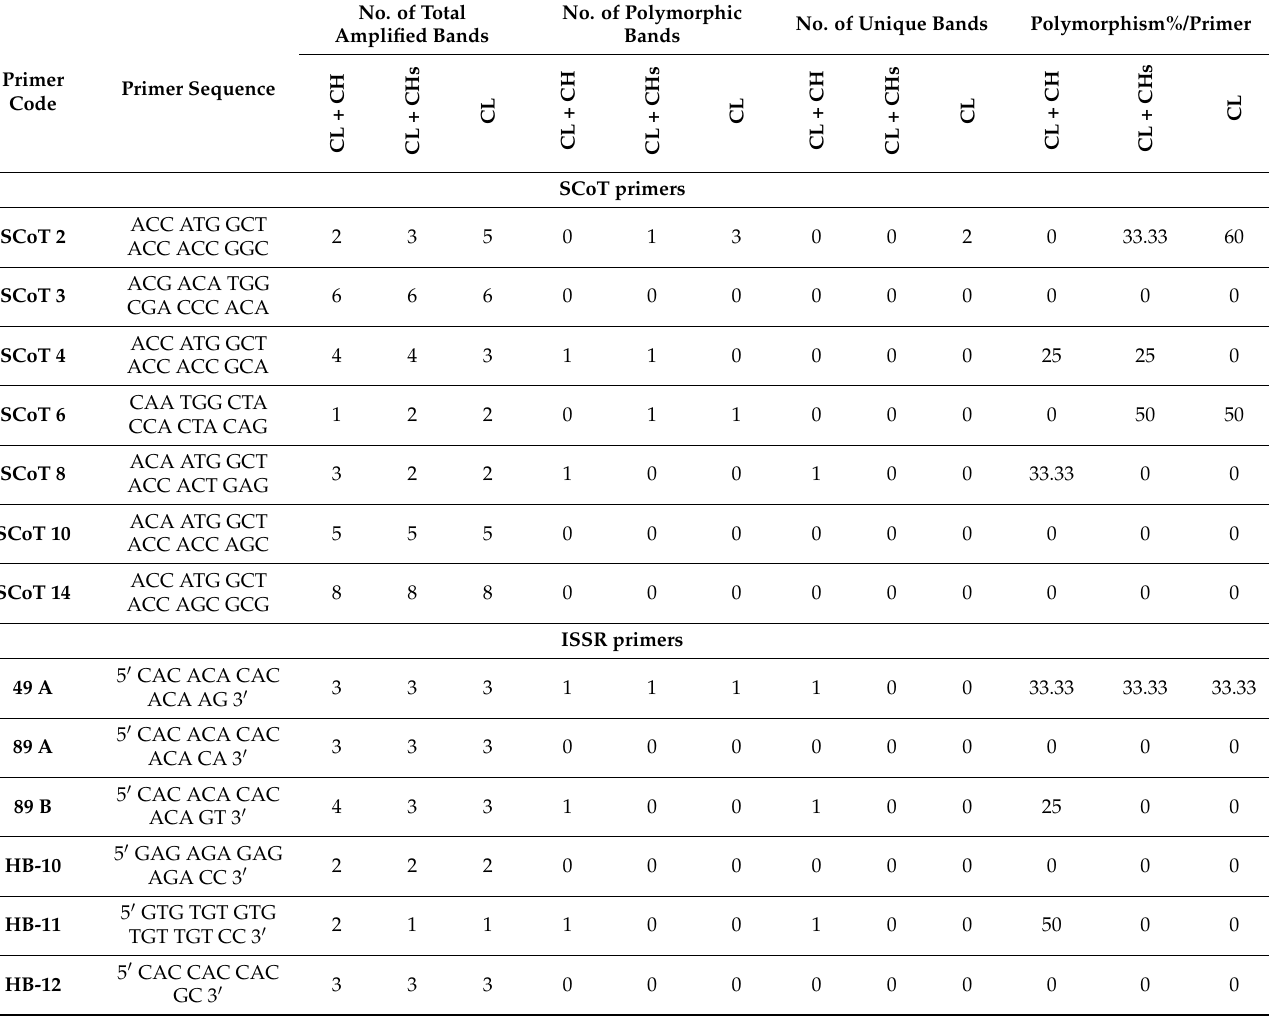
Table 3. Data were retrieved from the ISSR and SCoT